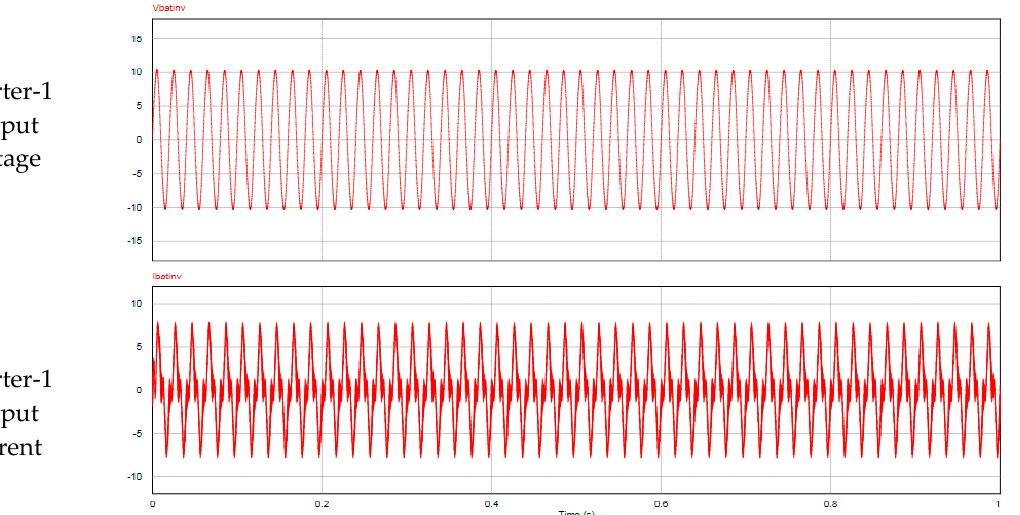
Figure 15. For mode-1 inverter 1 output (fed by battery).